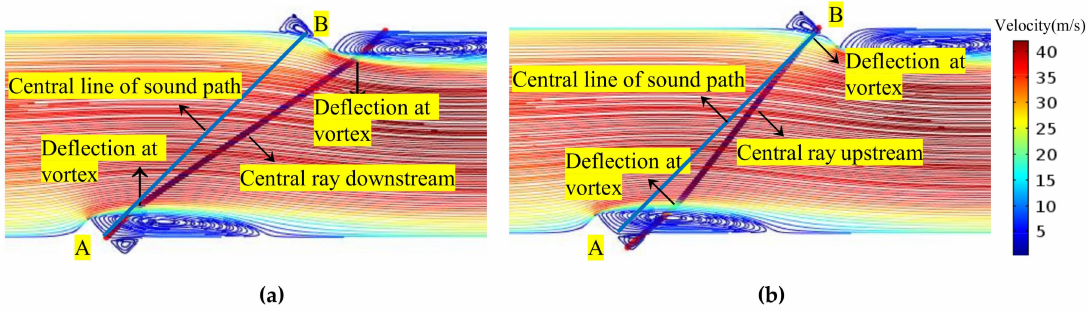
Figure 5. Central acoustic ray in flow field (the PR profile, v = 31.86 m/s). ( a ) Downstream; ( b )